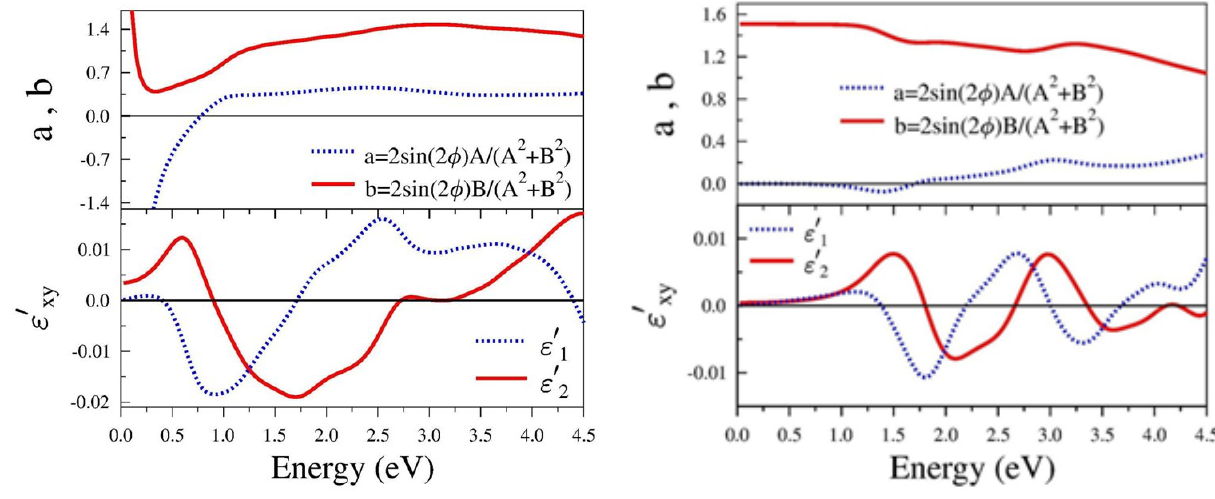
Fig. 5. Calculated a, b factors and off-diagonal components of the dielectric tensor iε ′ Co, right panel – 28%